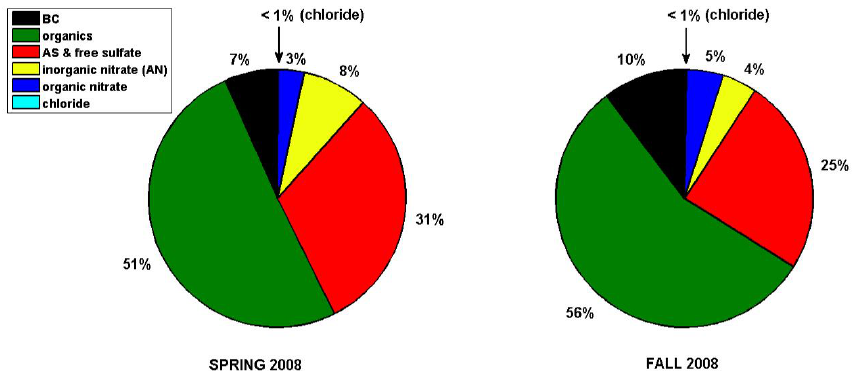
Fig. A1. Median aerosol chemical composition during AMS measurement campaigns in spring and fall 2008. Ammonium has been divided to sulfate and nitrate to form ammonium sulfate (AS) and ammonium nitrate (AN). Nitrate that is not neutralized by ammonium is assumed to be organic nitrate.